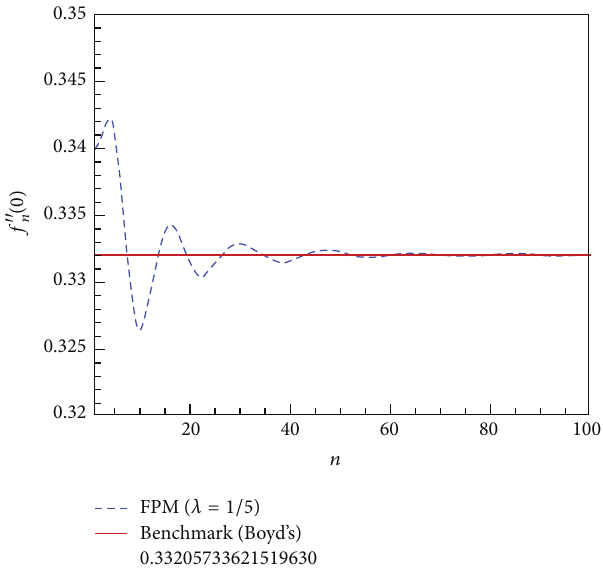
Figure 2: The convergence history of 𝑓 󸀠󸀠 𝑛 (0) ( 𝜆 = 1/5